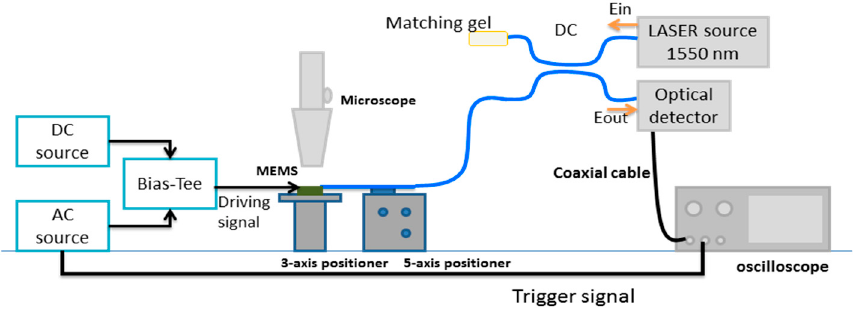
Figure 12. Optical characterization setup of the MEMS actuators using Fabry-Perot interferometer between the optical fiber and the micromirror attached to the MEMS actuators.